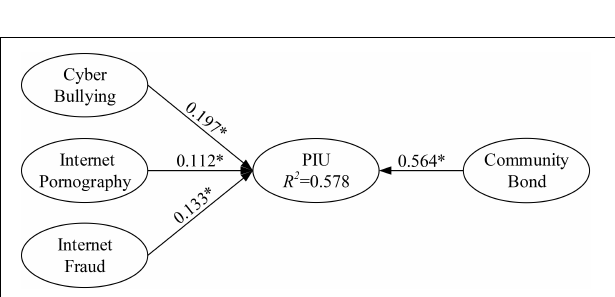
FIGURE 2 | Path coefficients for the research model (excluding moderator main effect).